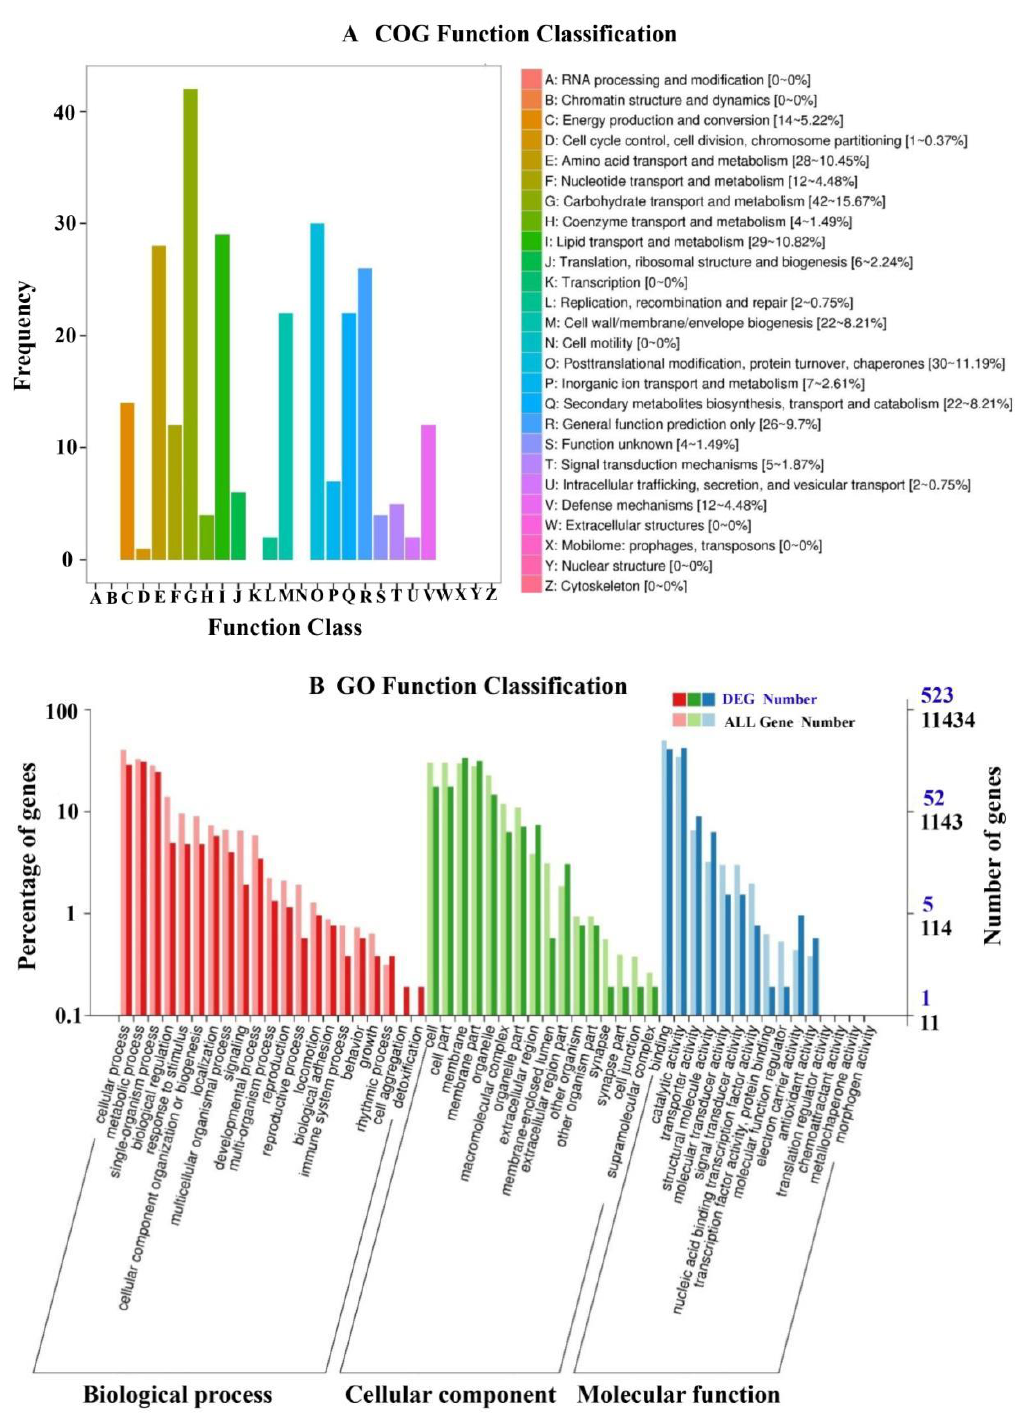
Figure 2. ( A ) COG function classifications of the differentially expressed genes (DEGs). ( B ) GO function classifications of DEGs. The X -axis represents names of function classification, and the Y -axis corresponds to the number of genes in each function classification.